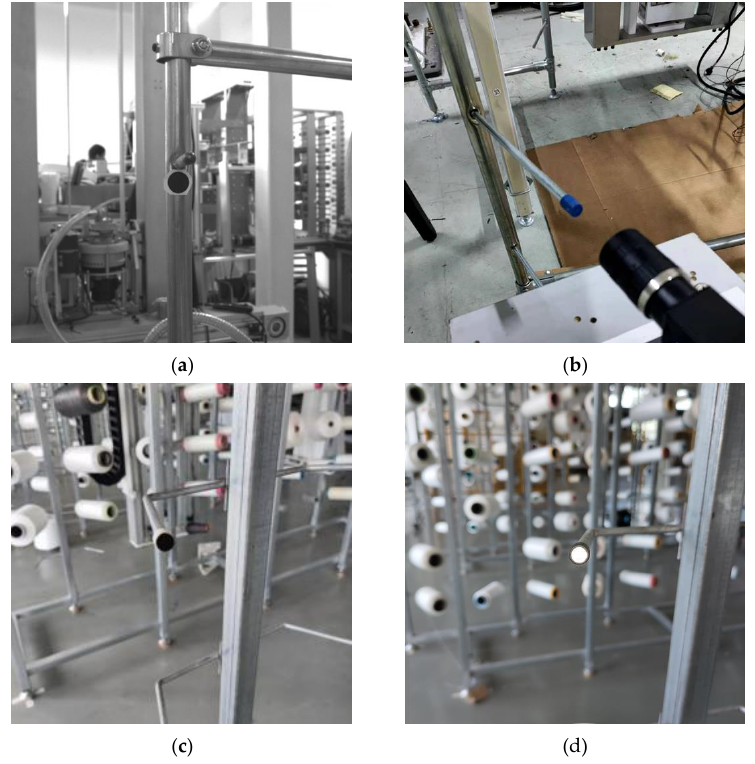
Figure 5. Shows the installation drawing of markers. ( a ) Physical installation drawing of disc marker; ( b ) Physical installation drawing of blue surface cover; ( c ) Physical installation drawing of black surface cover; ( d ) Physical installation drawing of reflective surface cover.